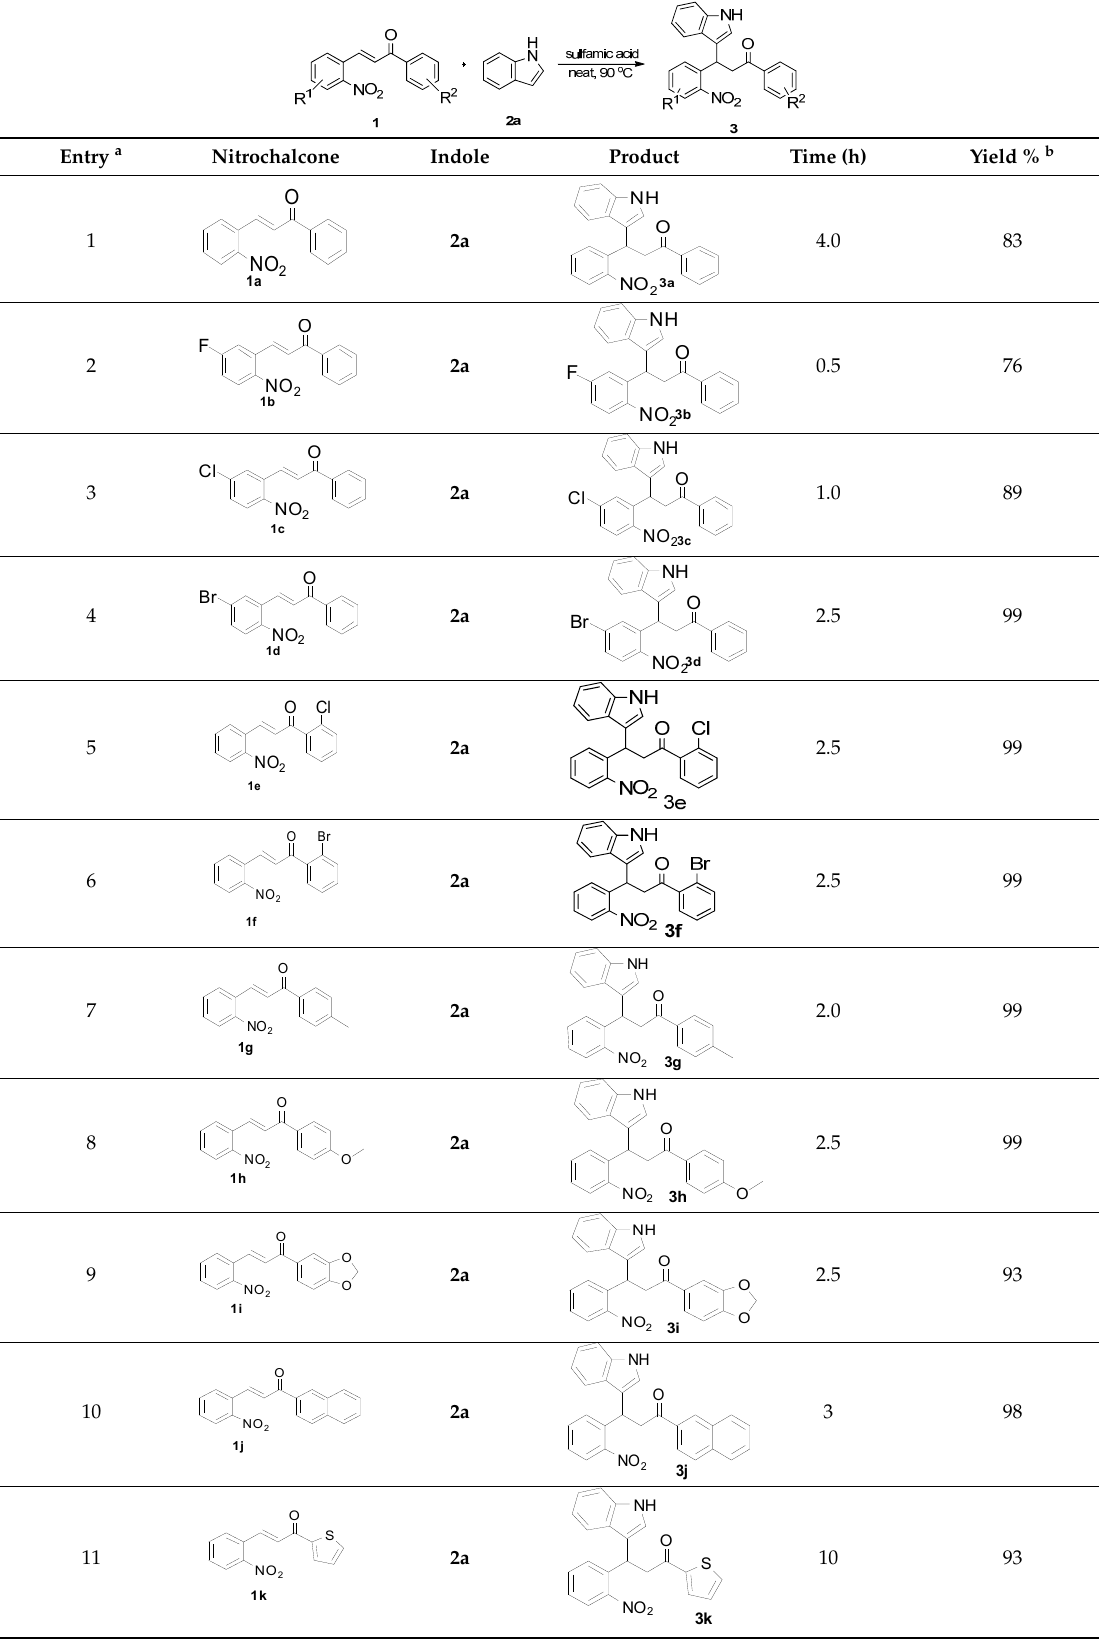
Table 1. Michael addition of various 2-nitrochalcones and indole.